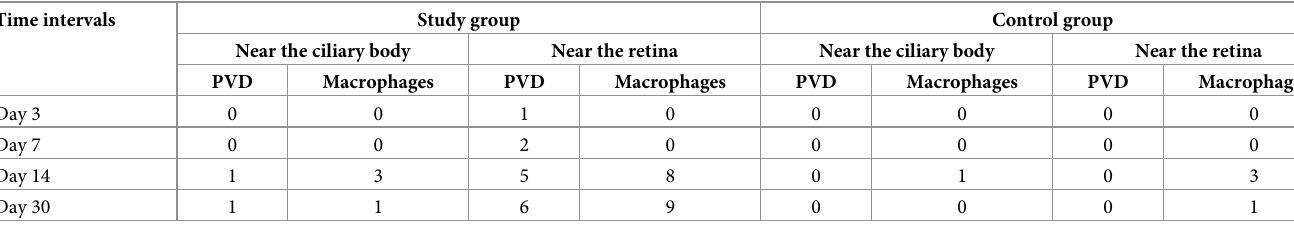
Table 3. PVD and average number of macrophages according to intervals of time (n = 8). Time intervals Study group Control group Near the ciliary body Near the retina Near the ciliary body Near the retina